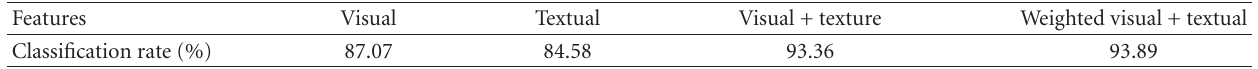
Table 2: Overall classification rates on medical evaluated dataset using combination of di ff erent